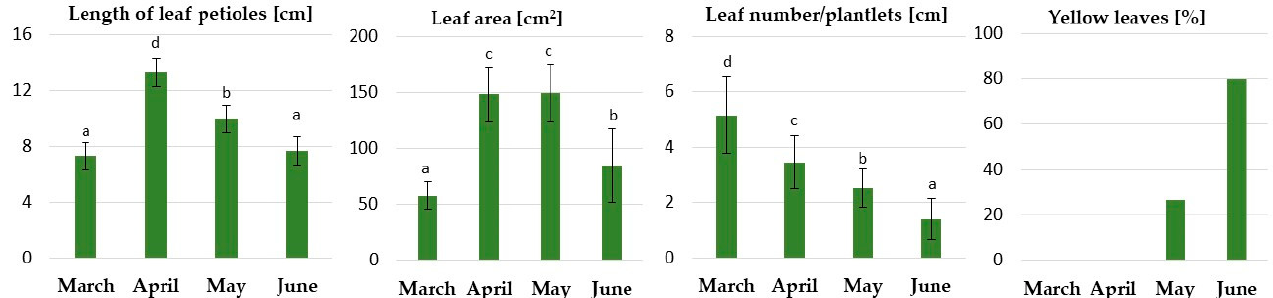
Figure 9. The effect of a long day and natural temperature in the greenhouse from early March to the end of June on ex vitro growth of micropropagated rhubarb ‘Raspberry’ plantlets. The daily maximum temperature was 22.3 °C, 23.1 °C, 28.9 °C and 34.0 °C in March, April, May and June, respectively. According to Duncan’s test ( p = 0.05), the means marked with the same letter within each growth parameter do not differ significantly. Error bars represent standard deviation.